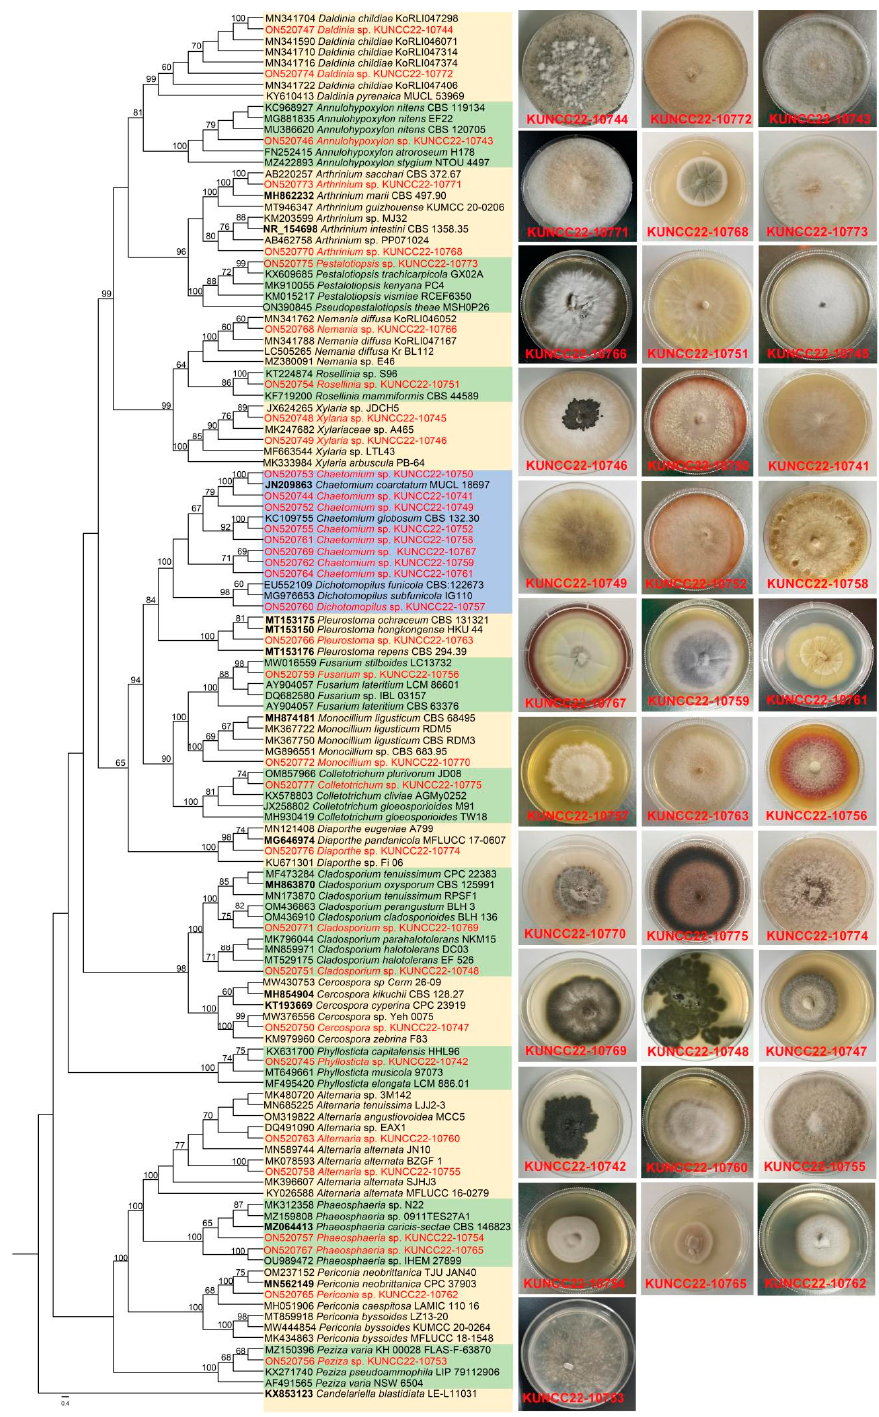
Figure 2. The left side shows the phylogram generated from maximum likelihood analysis based on an ITS sequence dataset. The tree is rooted with Candelariella blastidiata (LE-L11031). The